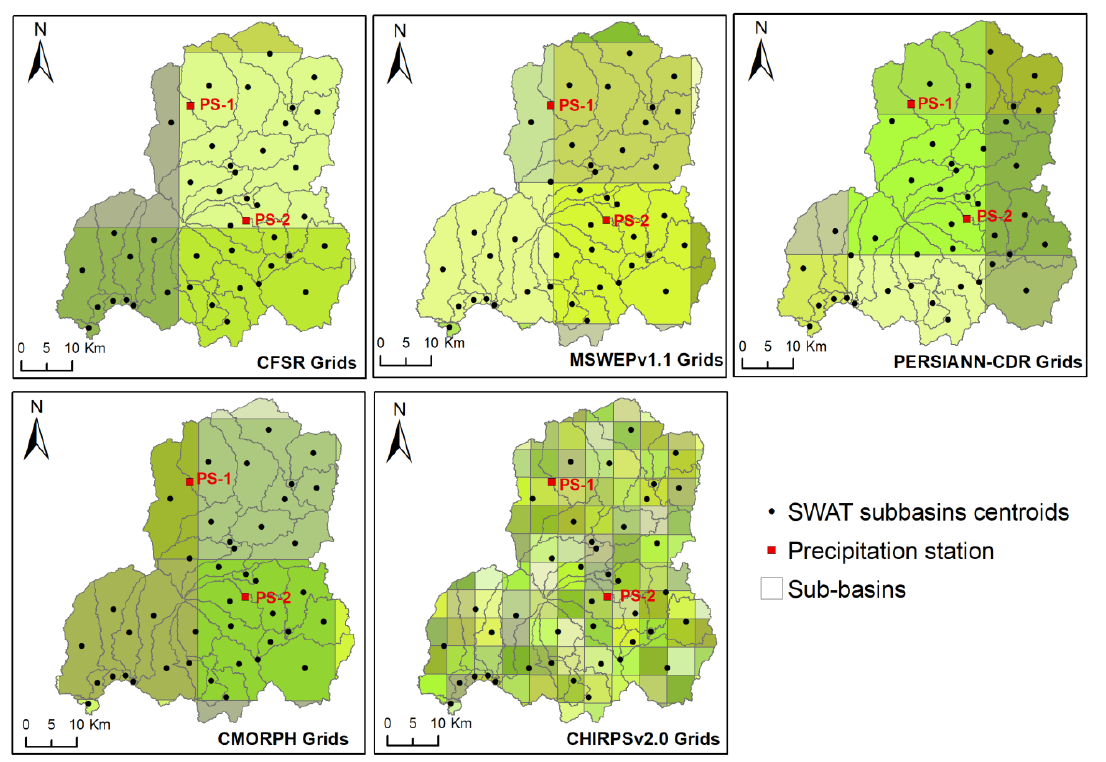
Figure 3. Precipitation grids with the sub-basin centroids.